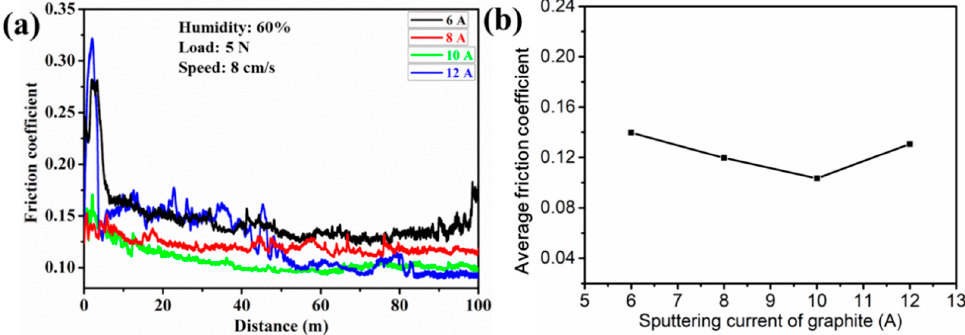
Figure 6. ( a ) Friction coefficients of TiC/GLC multilayer films as a function of sliding distance, ( b ) average friction coefficients of TiC/GLC multilayer films deposited at various sputtering currents.